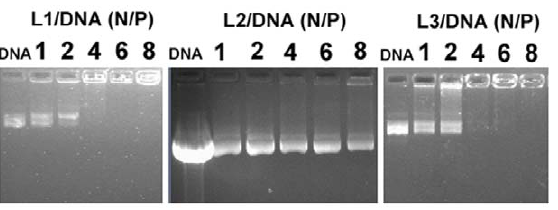
Figure 2. Electrophoretic gel retardation assays of liposomes/ DNA complexes (lipoplexes). The N/P ratios are indicated at the top of each lane. All lipid/DOPE ratios were 1 : 2 and the concentration of DNA was 5 m g/well.